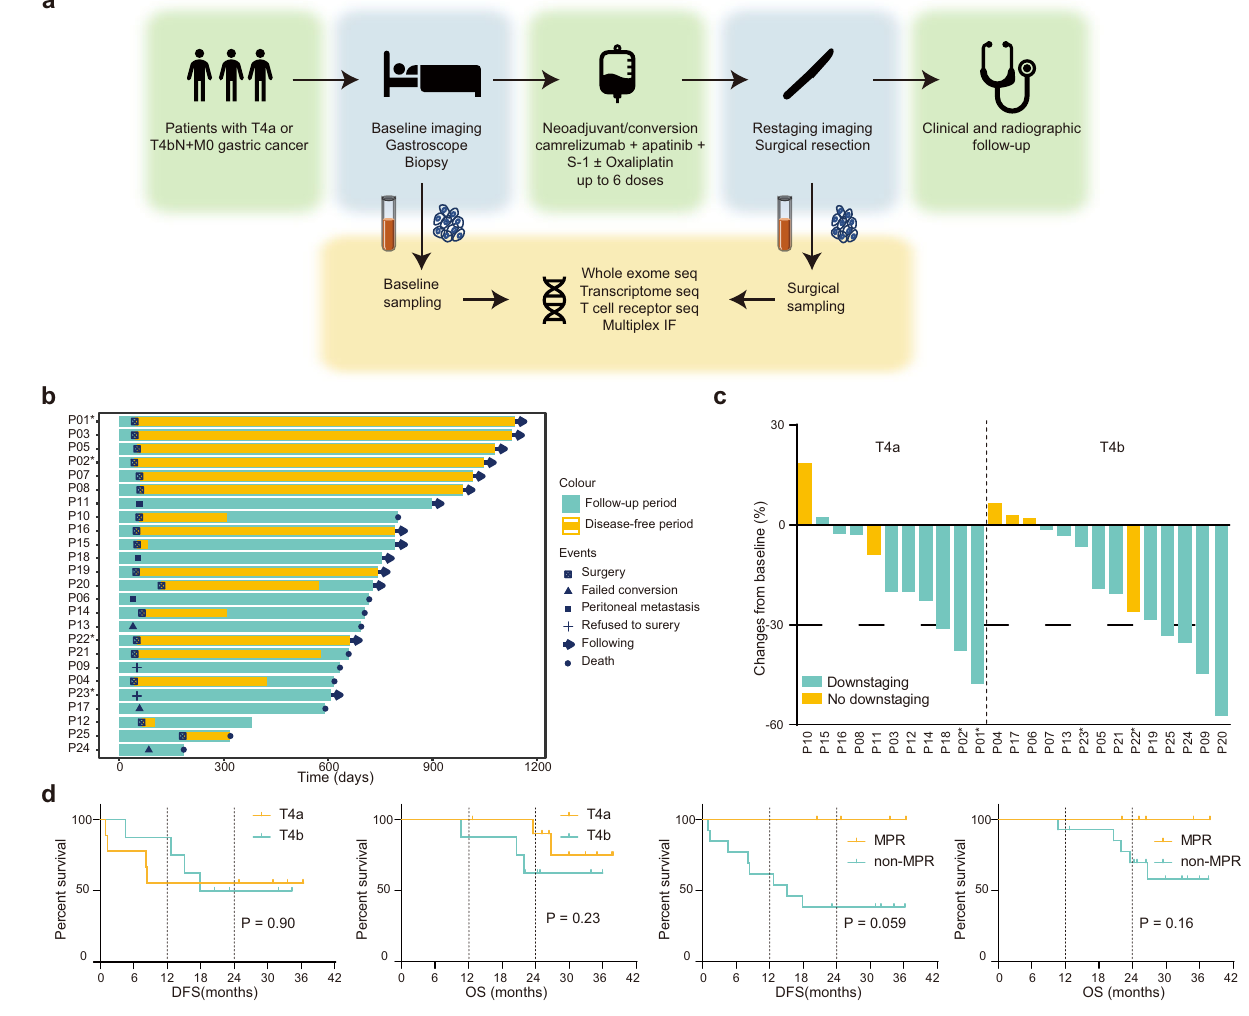
Fig.1|Studydesignandclinicalef fi cacy.a Trialschemaofthestudy.Patientswith cT4N+ received neoadjuvant camrelizumab, apatinib, S-1 with or without oxali- platin, followed by surgical resection. The primary endpoints were pathological responses and their potential biomarkers. Tumor and blood samples were col- lected at baseline and at the time of surgery for multi-omics analysis. b Swimmer plot of 25 patients involved in this trial. c Tumor size changes from baseline